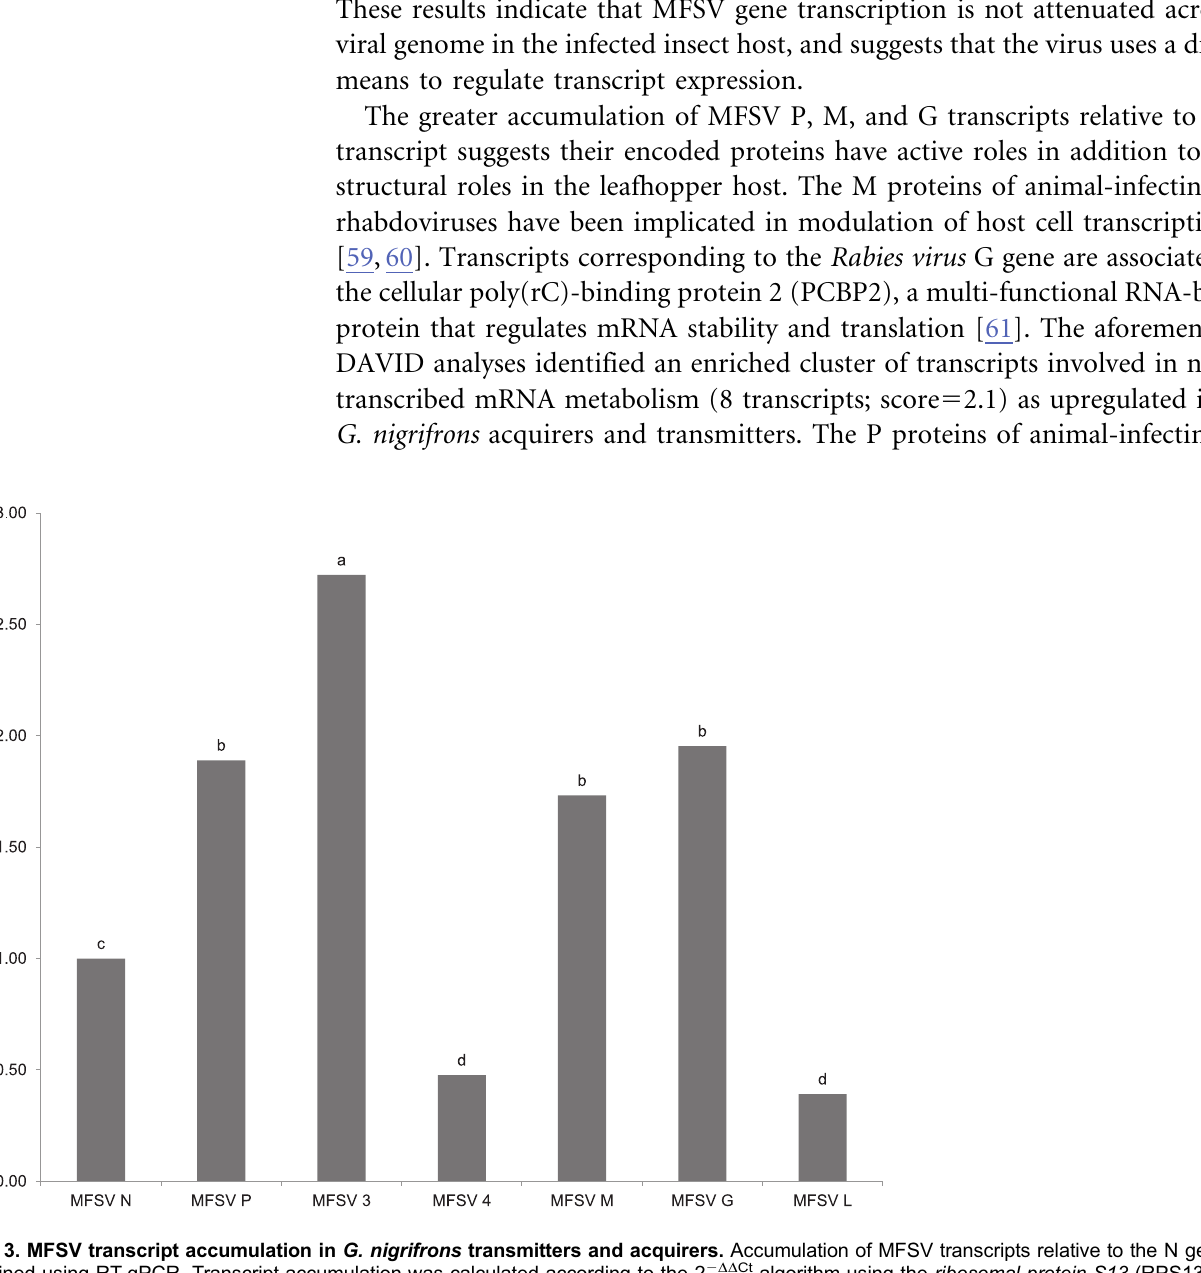
Figure 3. MFSV transcript accumulation in G. nigrifrons transmitters and acquirers. Accumulation of MFSV transcripts relative to the N gene was determined using RT-qPCR. Transcript accumulation was calculated according to the 2 2 DD Ct algorithm using the ribosomal protein S13 (RPS13) gene expression as the calibrator. Means for relative accumulation of each gene are shown. Bars with different letters were significantly different using LSD ( P , 0.05).